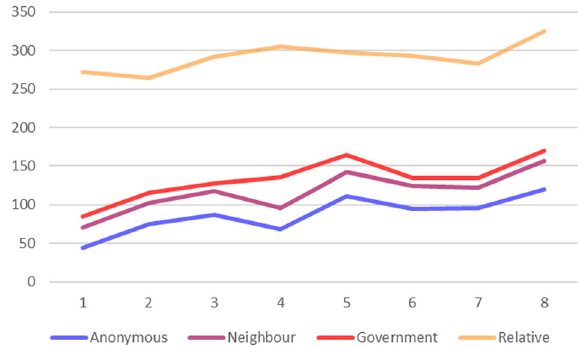
Fig. 6 Average donations by week. Mean donation recorded in each week of the 8-week experiment, by dictator game types.